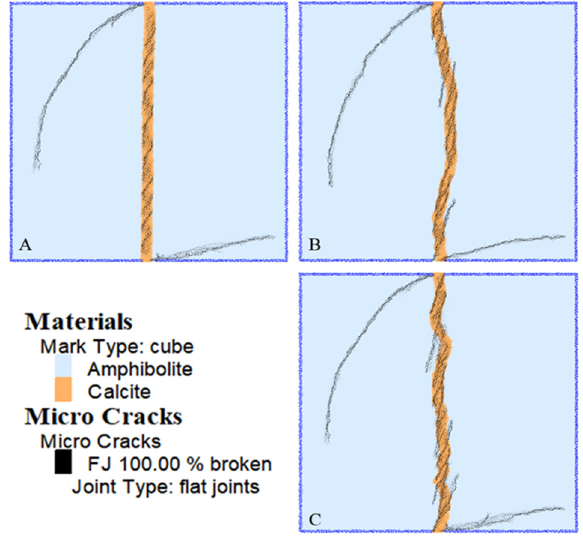
Figure 22. Failure mechanisms in calcite-infilled specimens with ( A ) 0-2 JRC profile, ( B ) 10-12 JRC profile, and ( C ) 18-20 JRC profile.